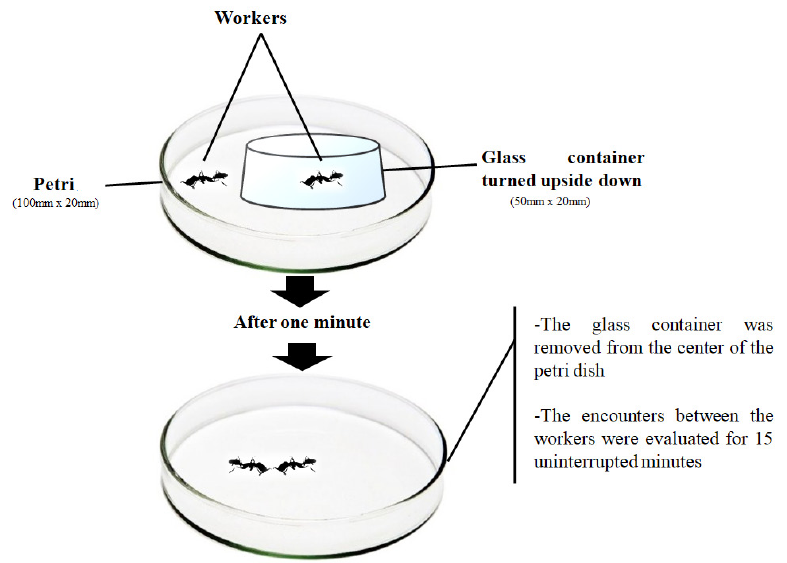
Fig 2. Scheme showing the procedure for the induced encounters between nestmate ants that had previously been maintained under different temperature conditions for 30